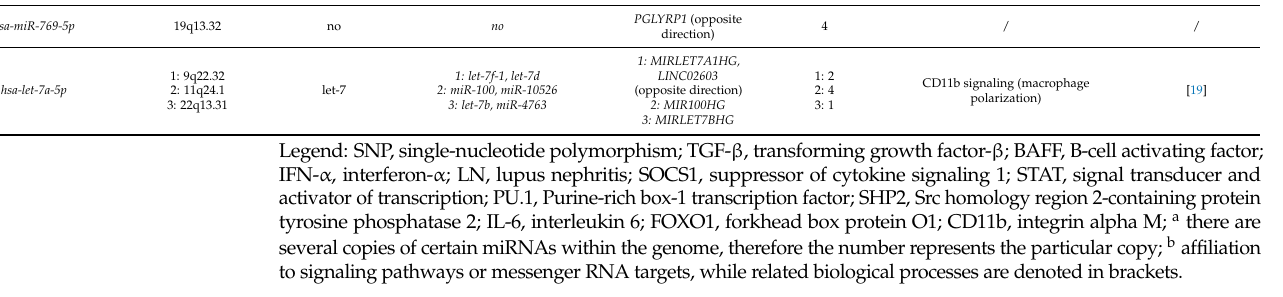
Table 4. Target identification for four AAV-specific miRNAs.